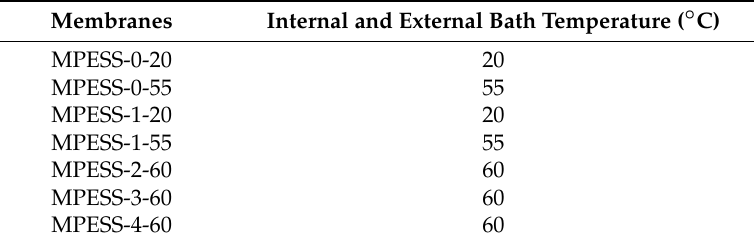
Table 2. Temperature of the membrane